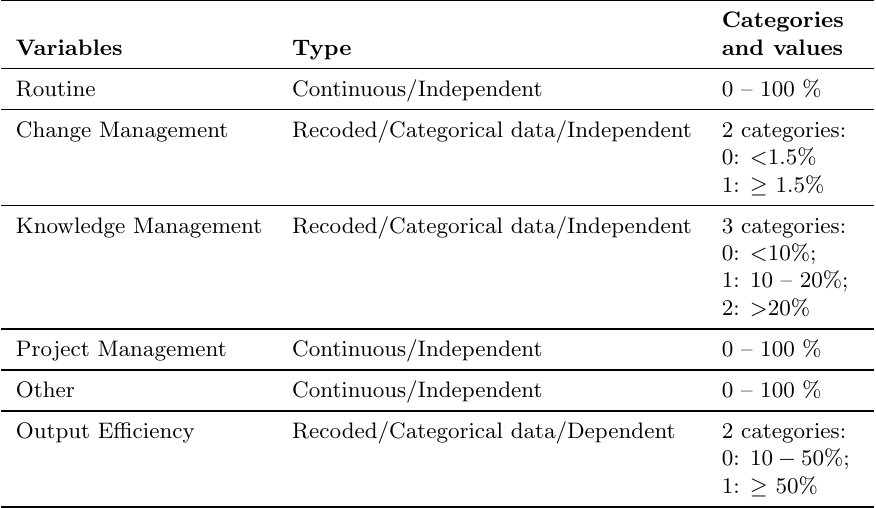
Table 3: Summary of the categories of the variables used to fit the